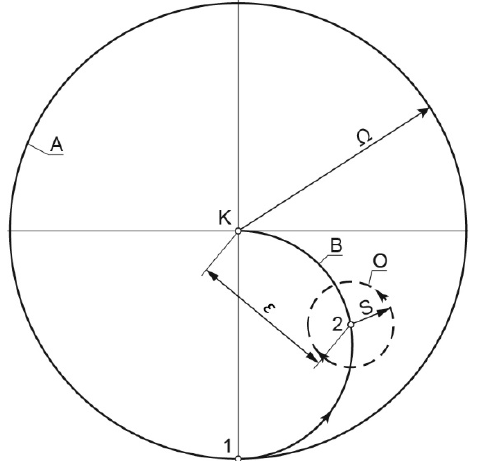
Figure 5. Model of the radial bearing. The trajectory of journal center: Ω —radius of the clearance circle. Ω = C /2; C —clearance in the bearing; A—circumference of clearance circle; B—path of average values of the journal center trajectory; O—path of the variable component of journal center trajectory; 1—position before journal breaks away from the shell: h* min = 0, ε = 1; 2—average value of journal center trajectory for a specific speed: h* min > 0, ε < 1; K—center of the clearance circle: theoretical position of journal center for speed tending to infinity: h* min = 1, ε =